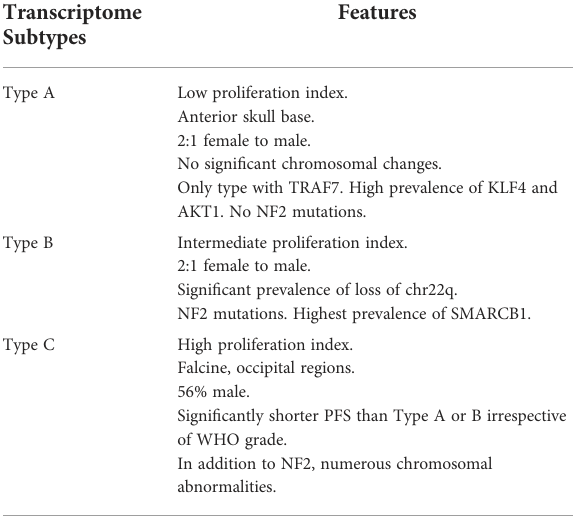
TABLE 2 Meningioma classi fi cation based on transcriptome